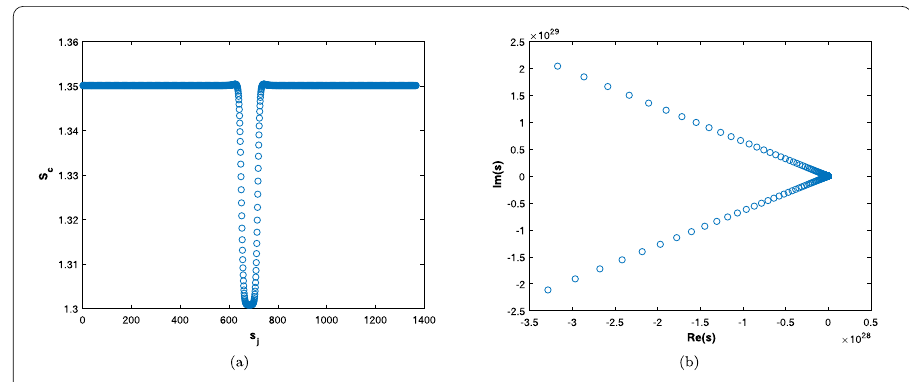
Figure 1 ( a ) The plot of the stability constant S c for Example 2, with N = 35, n = 9, M = 70, and α = 0.3321 at t = 1. We see that 1.3008 ≤ S c ≤ 1.3504. It is observed that the upper and lower bounds for the